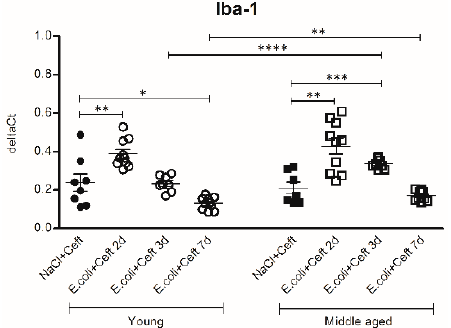
Figure 7. mRNA expression of brain homogenate of myeloid marker Iba-1, illustrated in deltaCts. Group size varies from n = 8 to 10. Parametric two-way ANOVA (factors : age and time point) was conducted and continuous variables were tested with post-hoc Student t -tests. Data represent mean ± SEM, * p ≤ 0.05, ** p ≤ 0.01, *** p ≤ 0.001, **** p ≤ 0.0001.